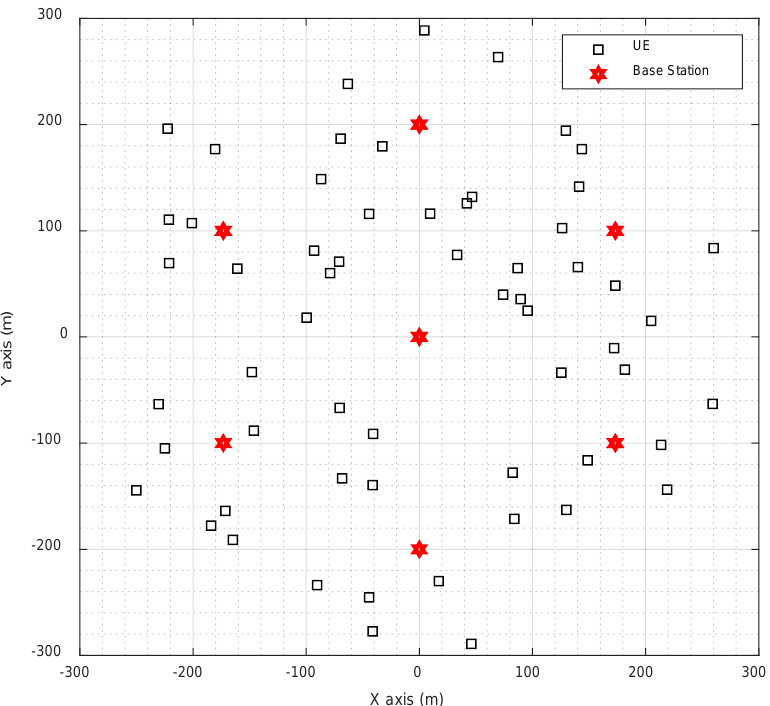
Figure 4. The distribution of base station and UE in UMi scenario.